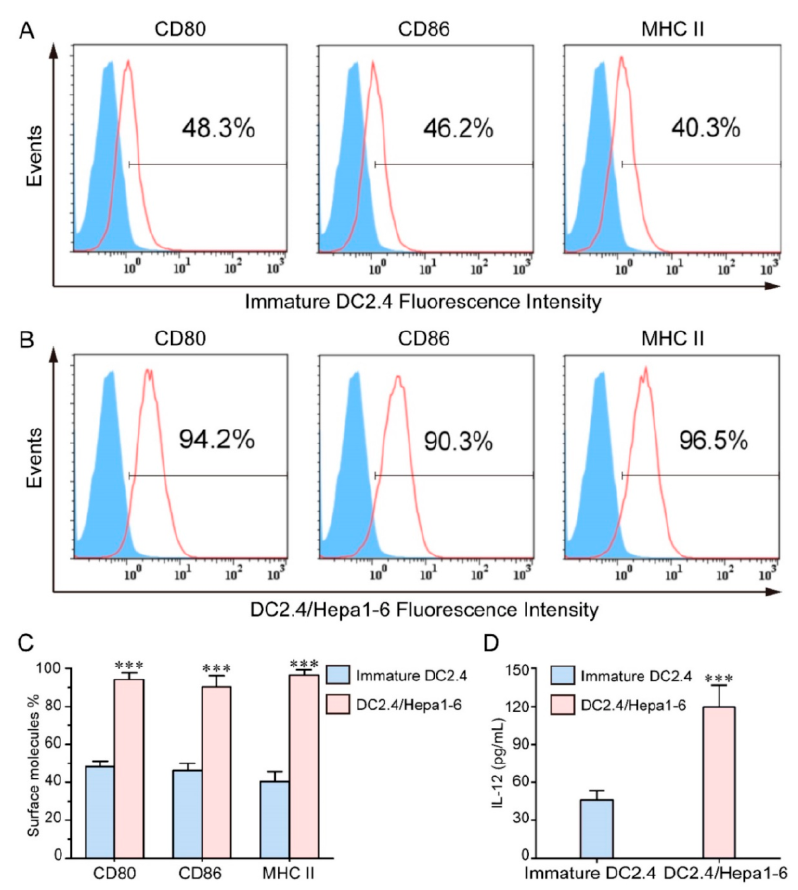
Figure 8. Expression levels of CD80, CD86 and MHCII. ( A , B ) Flow cytometry analysis; ( C ) Quantitative analysis; ( D ) The levels of IL-12 (*** p < 0.001) [40].